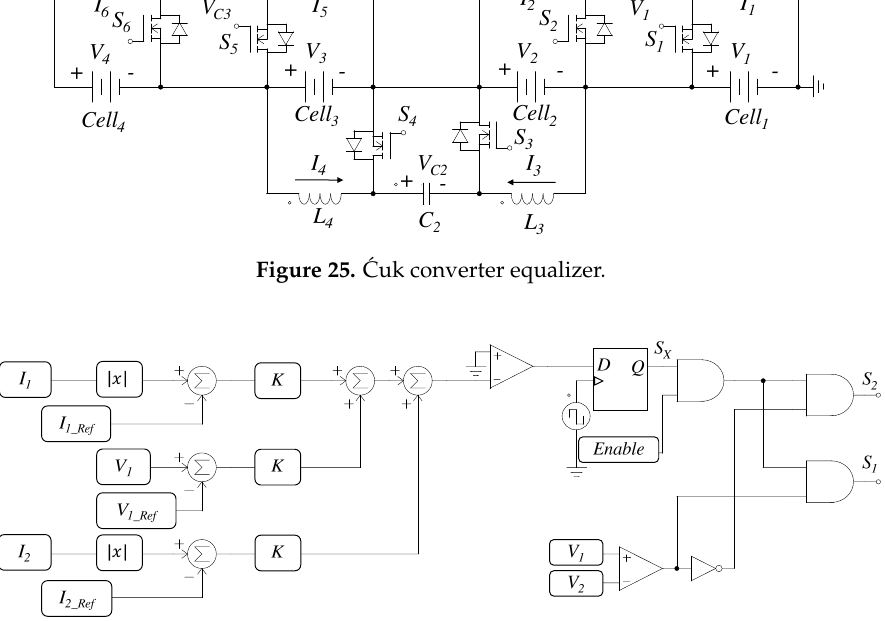
Figure 26. Controller required for the ´Cuk converter